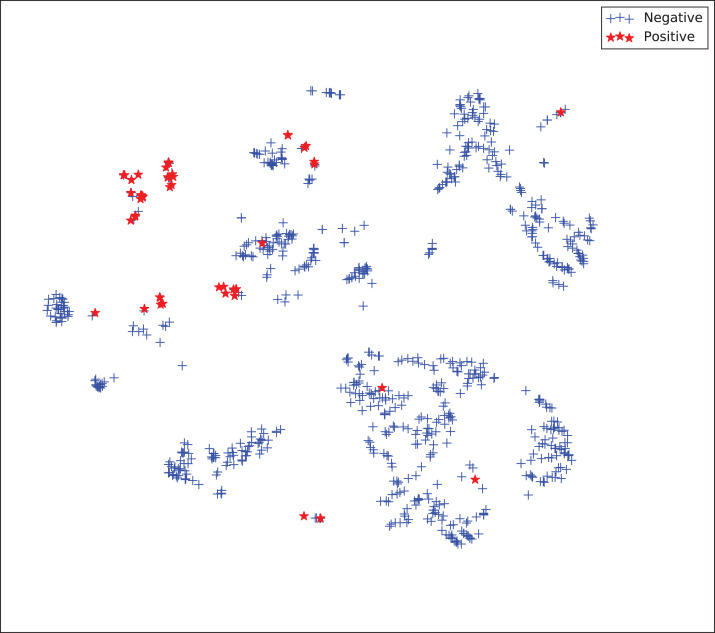
Two-dimensional projection of the semi-supervised embedding using t-distributed stochastic neighbor embedding (t-SNE) (Van Der Maaten & Hinton, 2008).